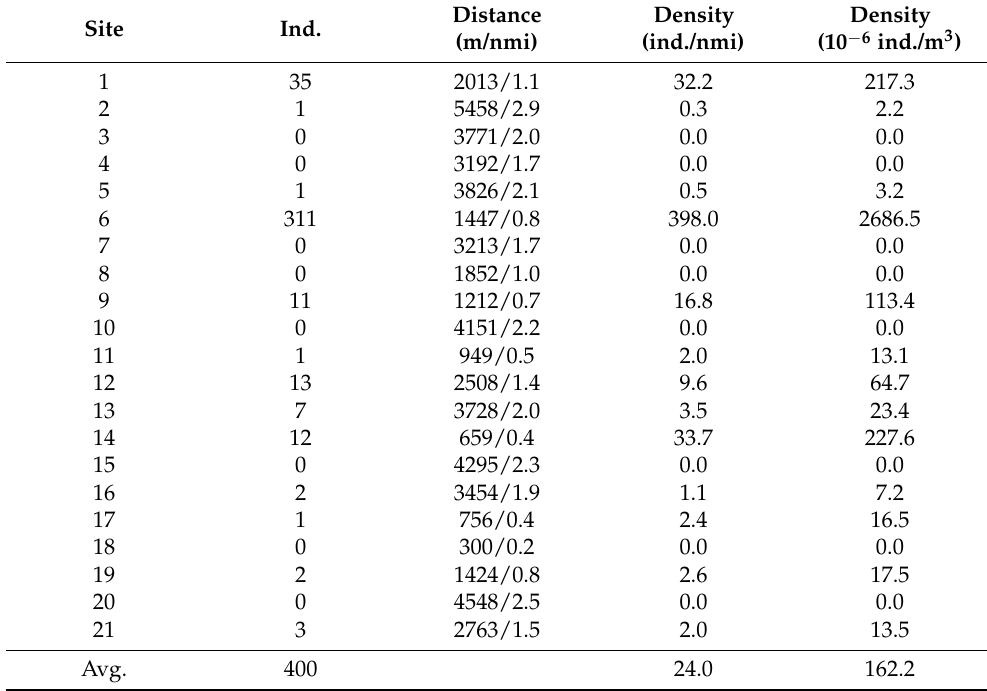
Table 3. Distribution density of jellyfish using the sighting survey method in the East China